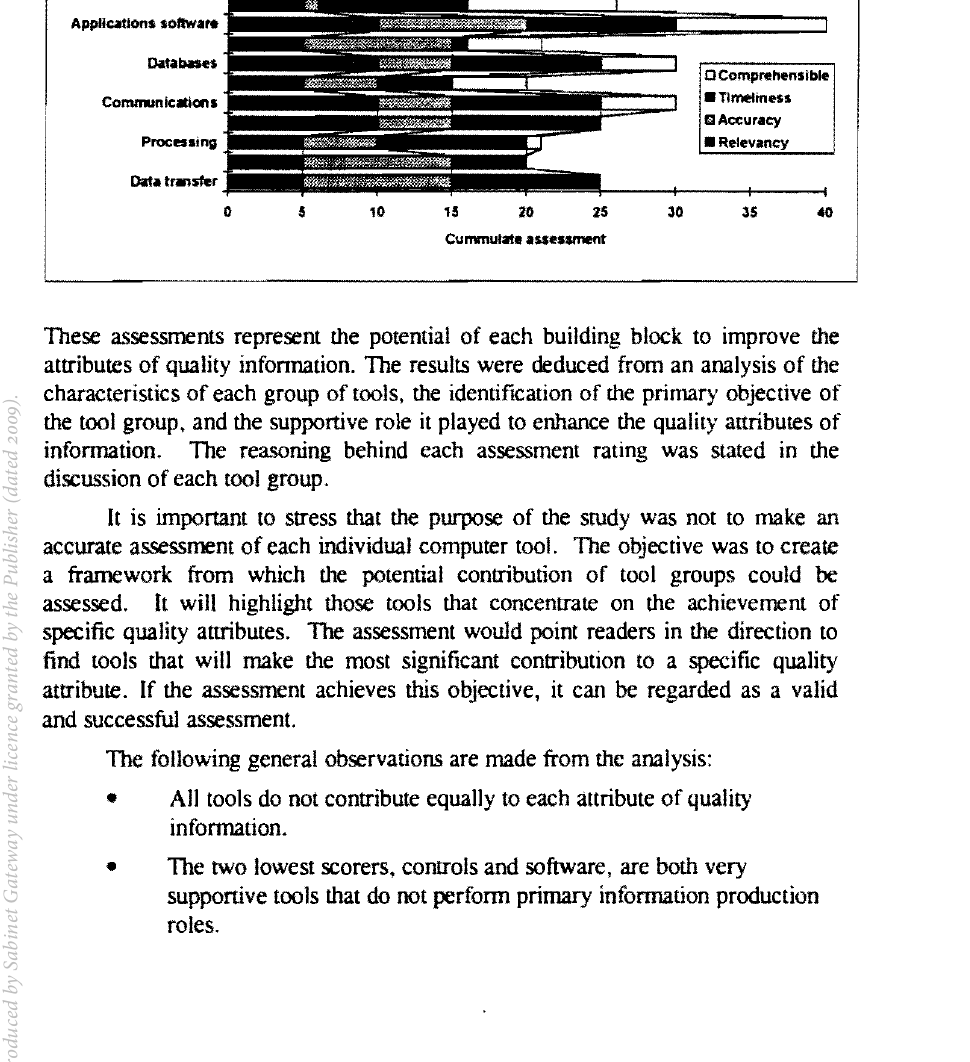
COMPARATIVE ANAlYSIS OF ASSESSMENT